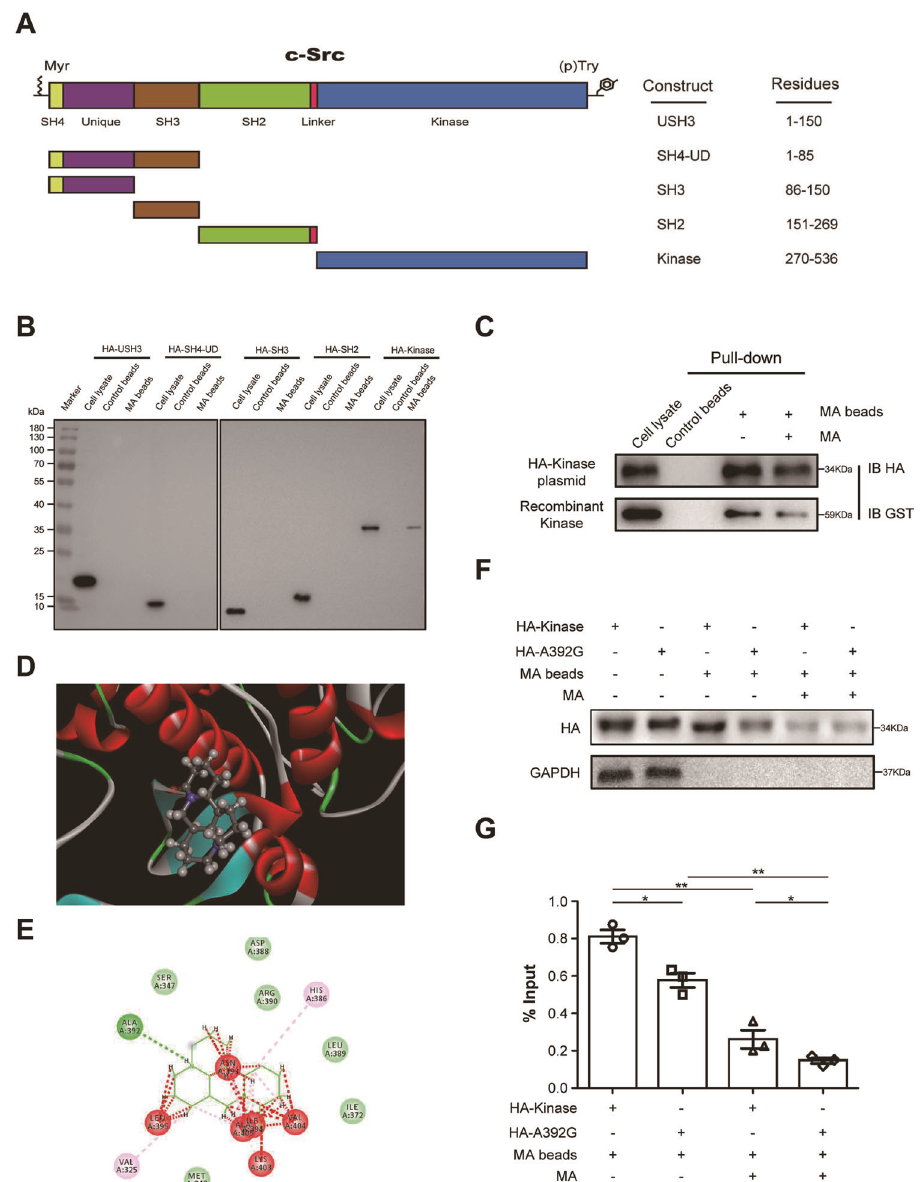
Fig. 3 Src kinase domain was required for its interaction with matrine. A Schematic of constructs with different functional domains of Src. USH3: 1 – 150 aa, SH4-UD: 1 – 85 aa, SH3: 86 – 150 aa, SH2: 151 – 269 aa, Kinase: 270 – 536 aa. B HA-tagged deletion constructs of Src, including HA- USH3, HA-SH4-UD, HA-SH3, HA-SH2, and HA-Kinase, were transfected into HEK-293 cells, respectively. Cell lysates were harvested and incubated with MA beads or control beads and blotted by anti-HA. C Constructs containing Src kinase domain were overexpressed in HEK-293 cells and expressed in BL21 cells, respectively. Competition assay results showed that cell lysates transfected with HA-Kinase plasmid and recombinant protein were pulled down by MA beads, which were reduced by adding an excess amount of MA. D Molecular docking diagram of matrine bound to Src kinase domain (PDB: 1YOJ). Matrine depicted as the ball-and-stick model showing carbon (gray), hydrogen (white), oxygen (red), and nitrogen (blue) atoms. E Hydrogen bonds between matrine and Src kinase domain were identi fi ed and indicated by green line. Van der Waals forces between matrine and Src kinase domain were indicated by pale green circles. F HEK-293 cells were transfected with plasmids pcDNA3.1-HA-Kinase and pcDNA3.1-HA-Kinase-A392G, respectively. MA beads were added to cell lysates for pull-down assay to detect matrine binding. G Densitometric quanti fi cation data of matrine binding followed by pull-down assay. Data are presented as mean ± SD ( n = 3, *P < 0.05, **P <